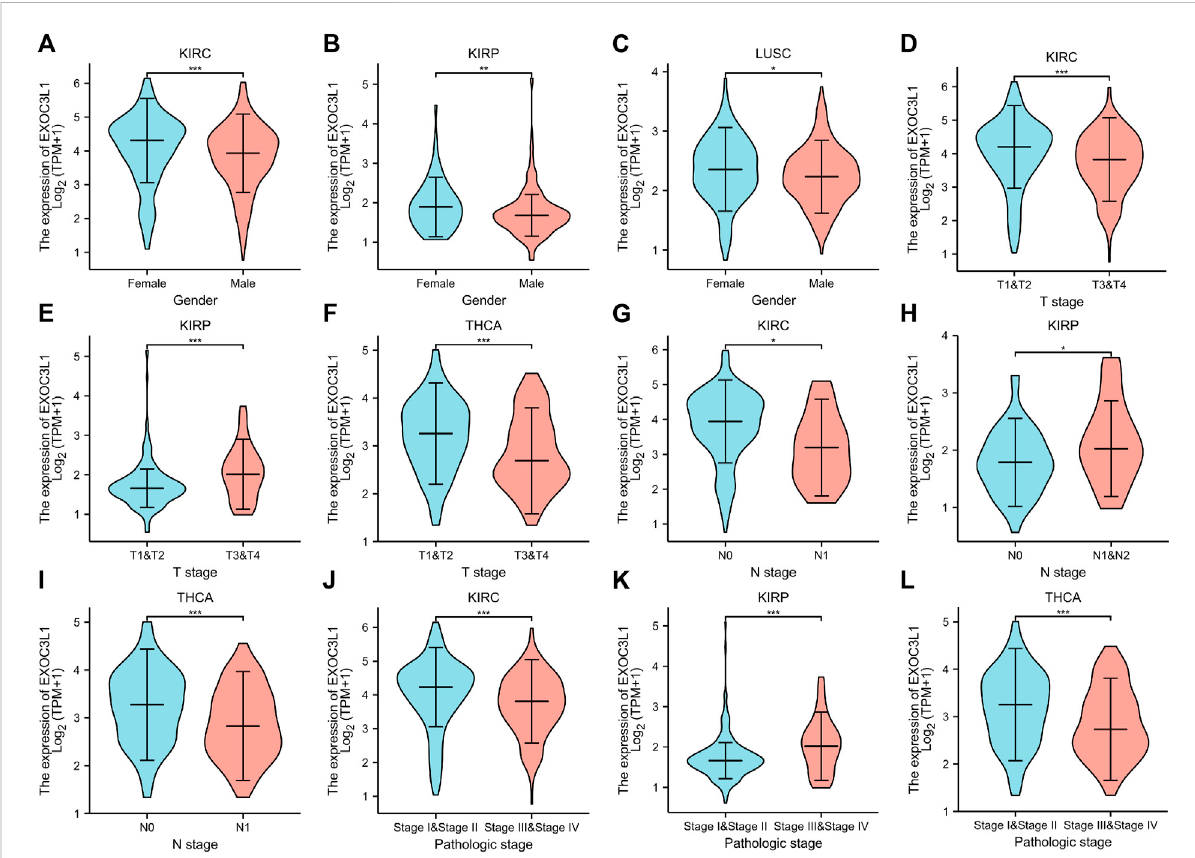
FIGURE 6 The correlation between EXOC3L1 expression and clinicopathological parameters. (A – C) EXOC3L1 expression was correlated with gender in KIRC, KIRP and LUSC. (D – F) Expression of EXOC3L1 was correlated with T stage in KIRC, KIRP and THCA. (G – I) EXOC3L1 expression was associated withNstageinKIRC,KIRPandTHCA. (J – L) EXOC3L1expressionwasassociatedwithpathologicstageinKIRC,KIRPandTHCA.(* p < 0.05;** p < 0.01; *** p <